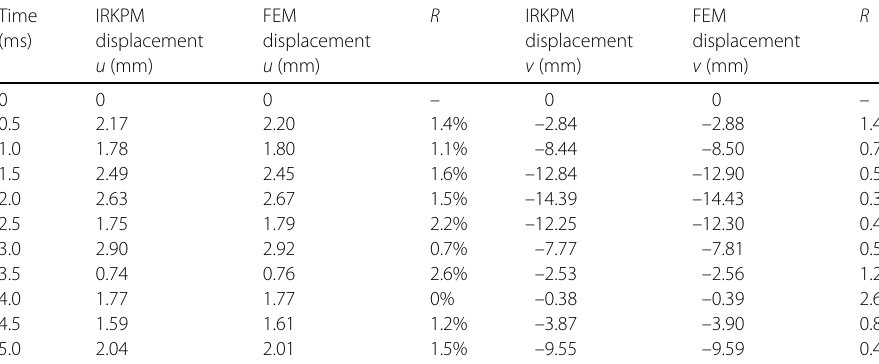
Table 2 The displacement v of the point